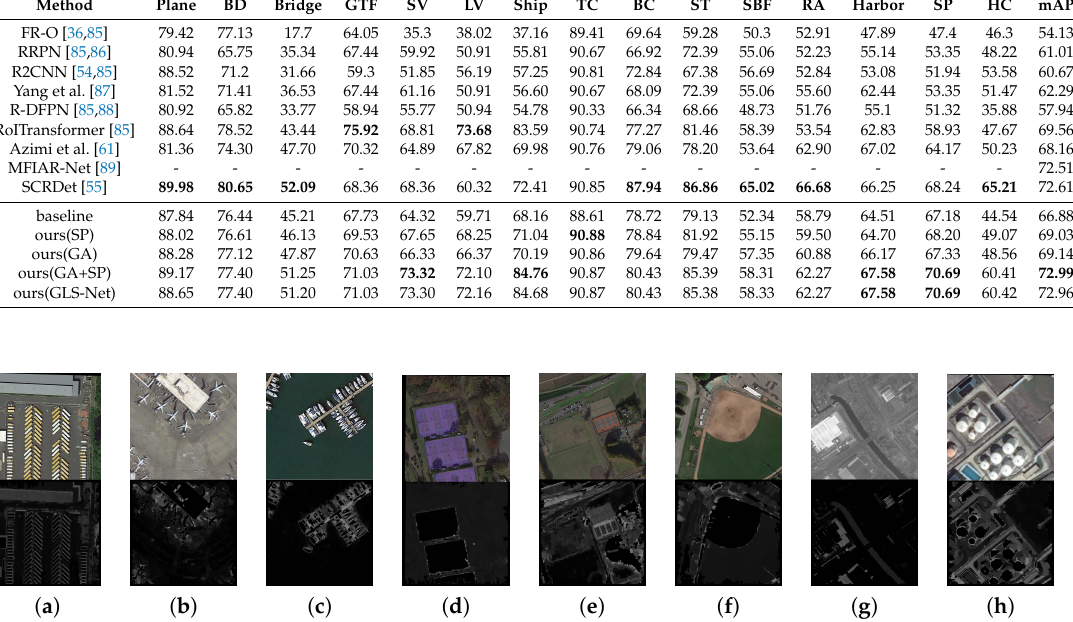
Figure 13. The saliency maps based on the RC algorithm [70]. The images of the above line come from the “A Large-Scale Dataset for Object Detection in Aerial images” (DOTA) dataset [11], and the images of the following line is the result of the RC algorithm. In addition, ( a – h ) are eight different scenarios. It can be seen that the saliency algorithm can reduce the interference of background information to a certain extent. In the local area, the difference between the object and the background increases, and the structural information of the object is